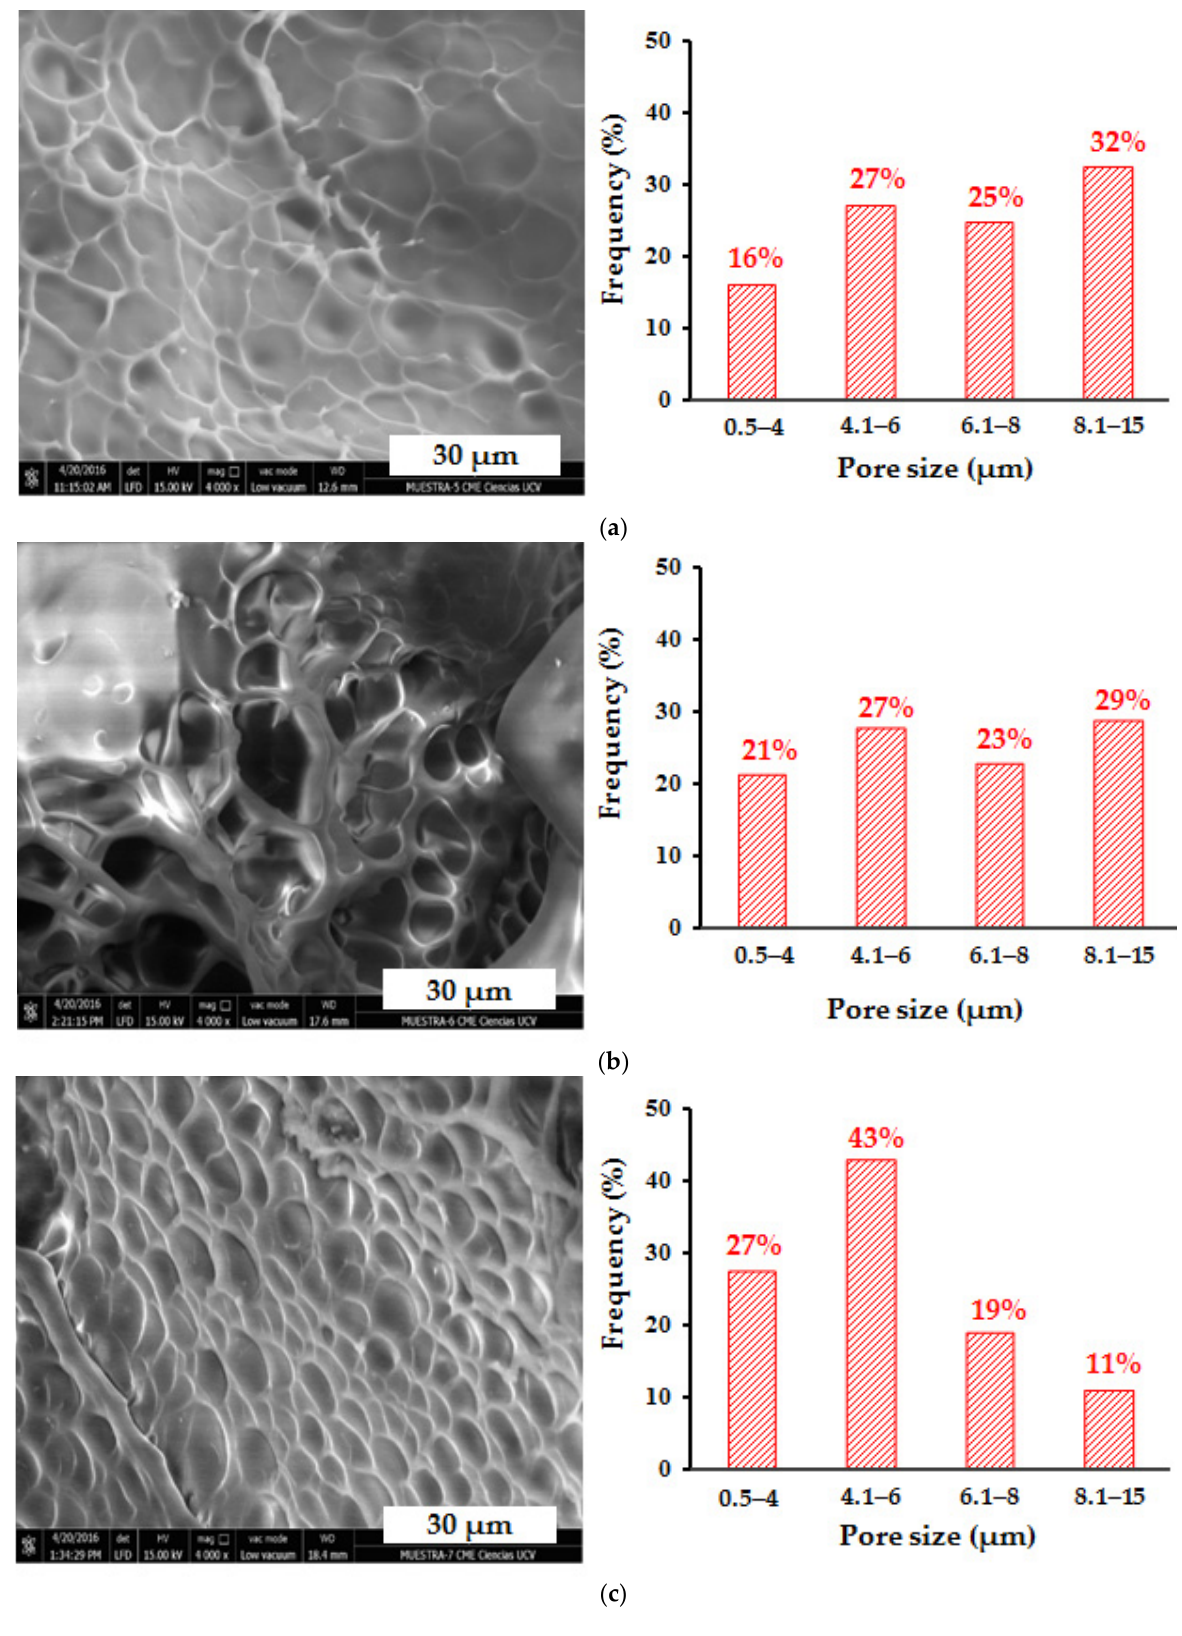
Figure 19. SEM micrographs for polyacrylamide/FeSiMn hybrid hydrogels: ( a ) PF0 (0.1% FeSiMn, n = 519), ( b ) PF1 (1% FeSiMn, n=203), and ( c ) PF10 (10% FeSiMn, n = 318).